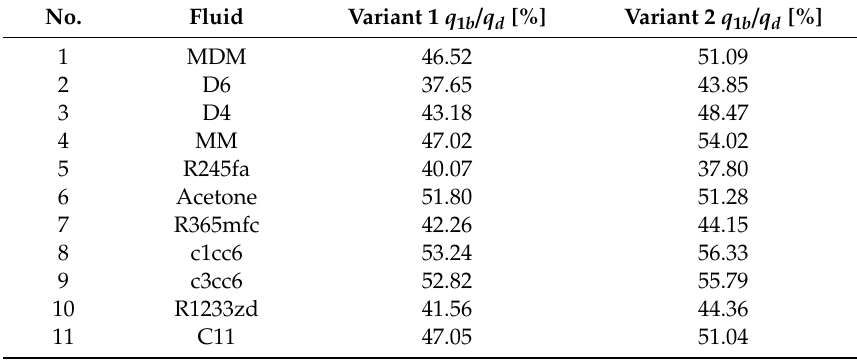
Table 4. Heat delivered during isothermal expansion ( q 1 b ) in relation to the total heat supplied in Table 1 and variant